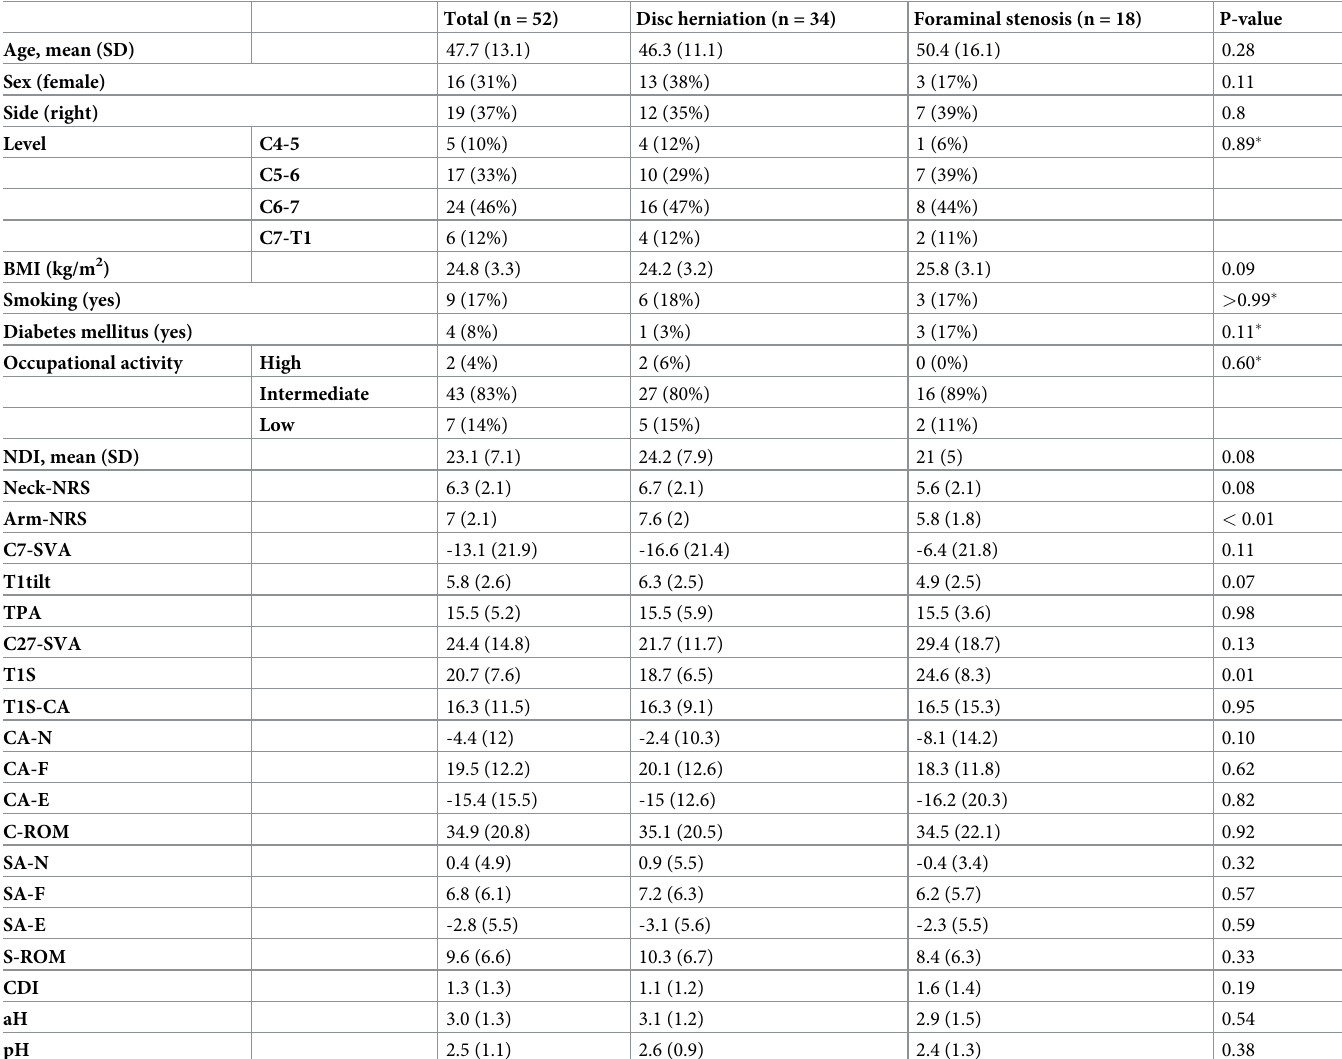
Table 1. Characteristics of